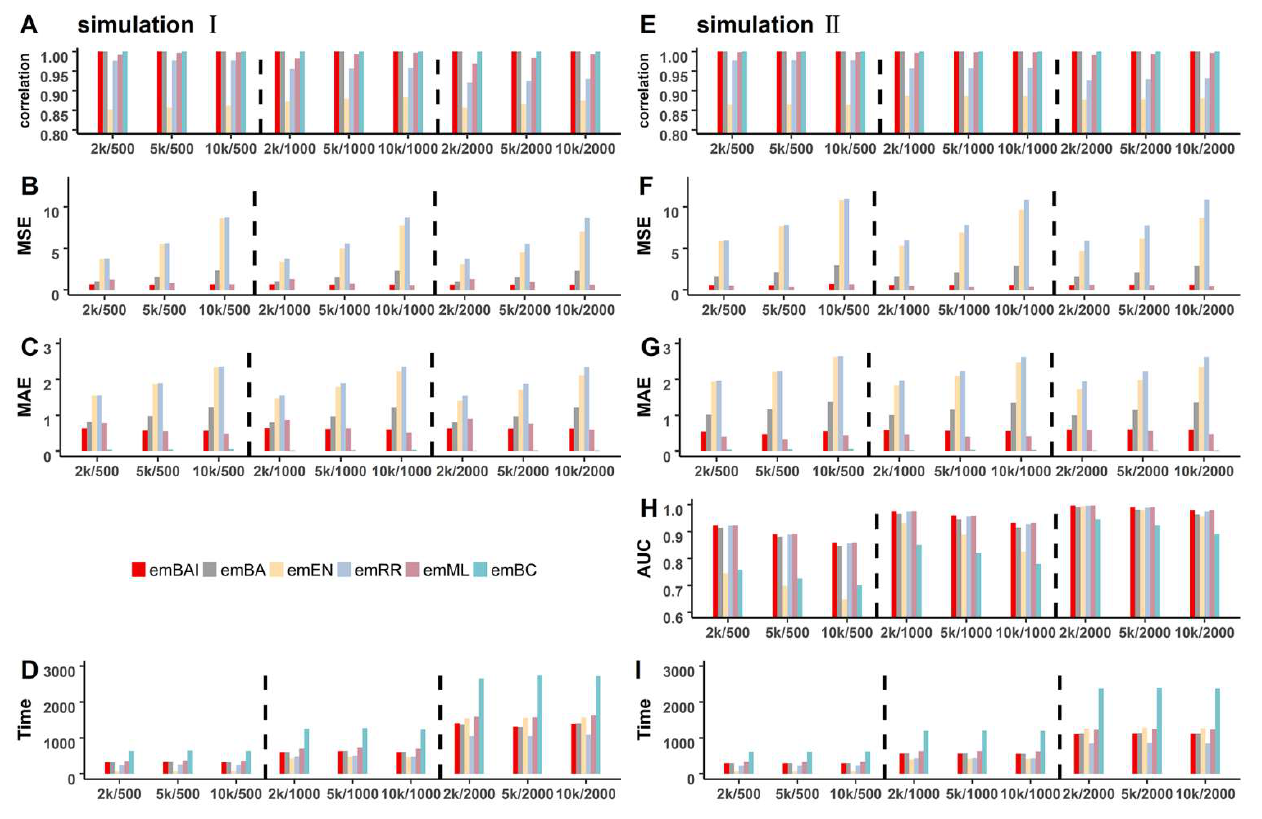
Figure 2. The correlation ( A , E ), MSE ( B , F ), MAE ( C , G ), AUC ( H ) and computing time ( D , I ) of two simulation experiments using emBAI, emBA, emEN, emRR, emML and emBC.